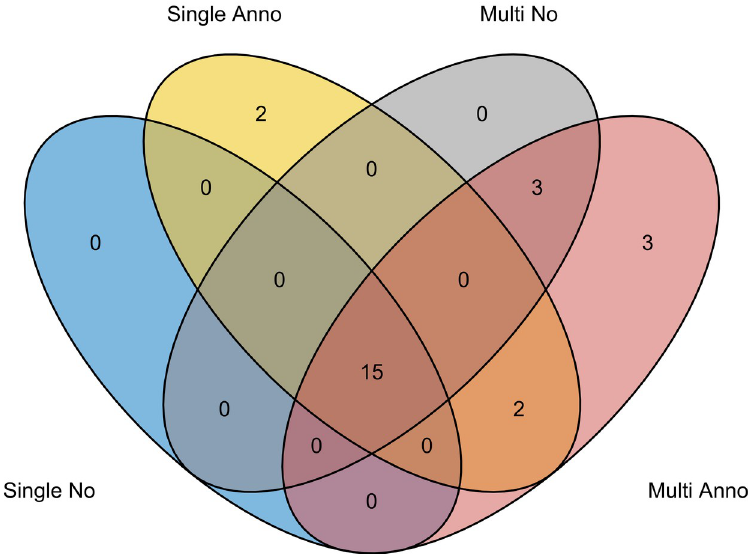
Fig 5. Venn diagram of identified genes in different models. Compared to the single-trait model without annotation, the single-trait model with annotations identified 4 additional genes. Compared to the multi-trait model without annotation, the multi-trait model with annotations identified 5 additional genes. In total, the multi-trait models identified 6 different genes compared to the single-trait models, including 4 novel human CHD genes ( CDK13 , FRYL , LZTR1 and NAA15